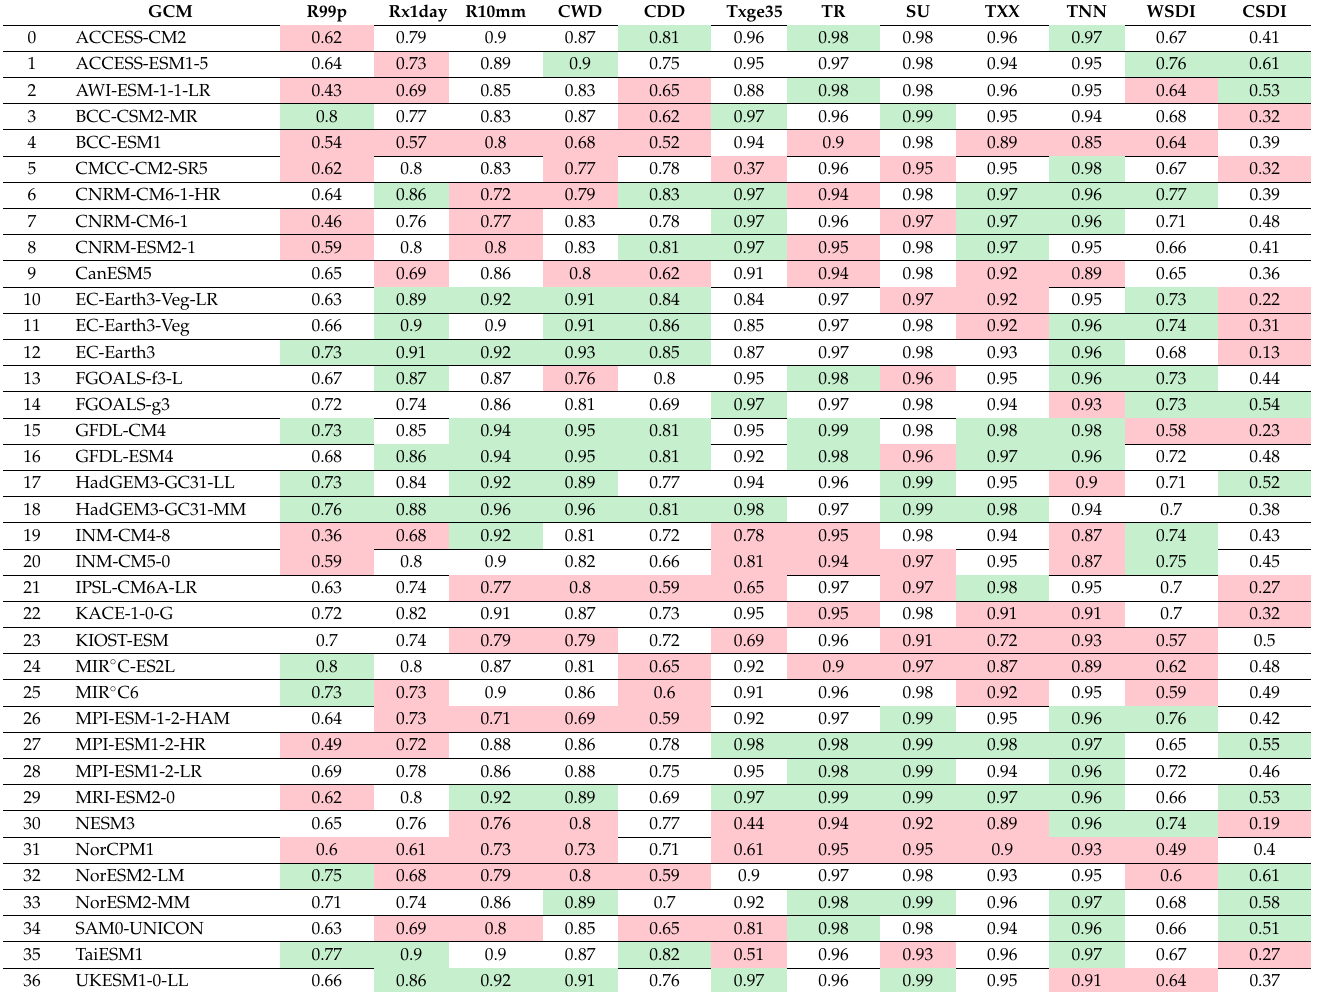
Table 5. Table of pattern correlation (PCorr) recorded in 37 CMIP6 GCMs for the 12 extreme indices. A larger value of PCorr corresponds to the better performance of GCMs. Here, the colour green and red denote the best (top 25% subset) and worst (bottom 25% subset) performing GCMs.